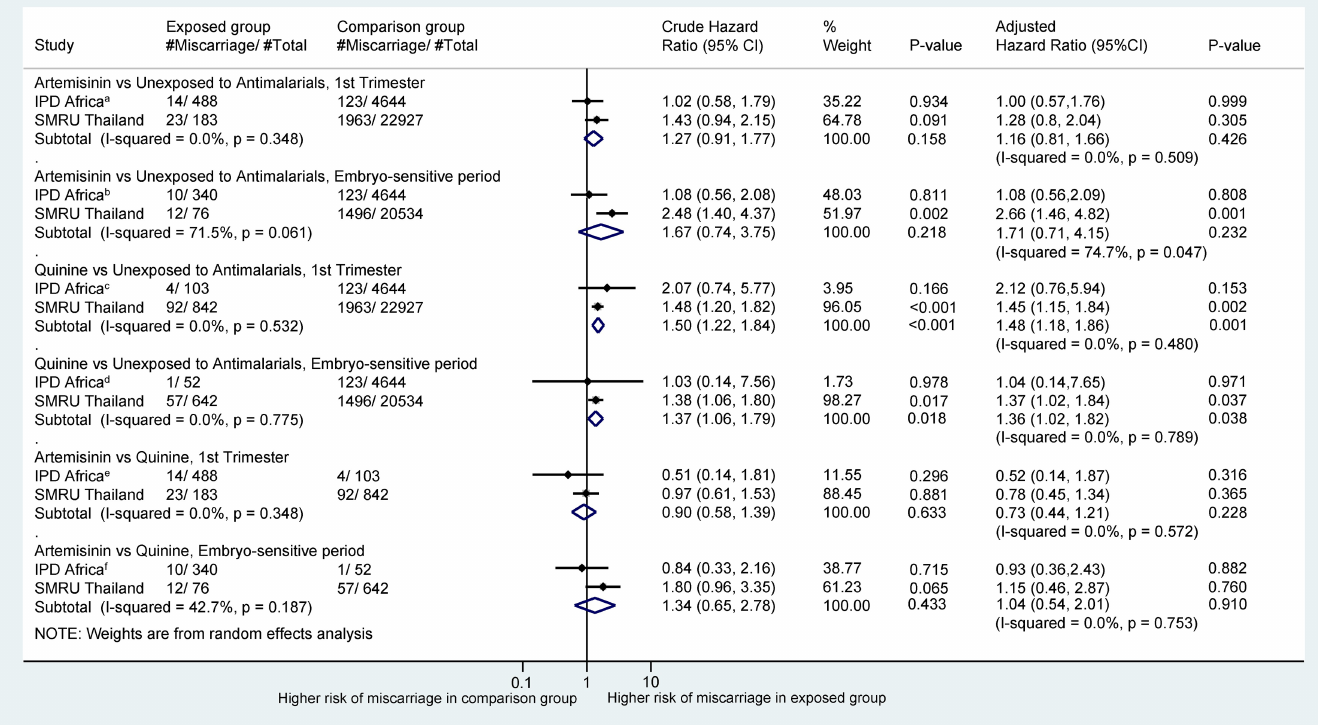
Fig 2. Forest plot for aggregated data meta-analysis of crude and adjusted hazard ratios for the association between different antimalarial exposure categories and miscarriage. HRs account for pregnancy week under observation through left truncation and treat exposureas a time-dependent variable. I 2 values are for IPD from Africa only: a 26.4%; b 26.0%; c 23.9%; d 30.5%; e 26.1%; f 28.9%. Crude HRs are adjustedfor clustering by site in the IPD arm. aHRs for IPD from Africa account for site, woman’s age, and gravidity. aHRs for the SMRU account for smoking, year of first consultation, gravidity, and non-malariafebrile morbidity in first trimester for the comparisonwith the unexposedgroup, while the comparisonbetweenthe artemisinin and quinine groups accounts for infectionseverity (asymptomatic, symptomatic, hyperparasitemic/severe), year of first consultation, and non-malaria febrile morbidity in the first trimester. aHR, adjustedhazard ratio; HR, hazard ratio; IPD, individualpatient data; SMRU, Shoklo Malaria Research Unit.